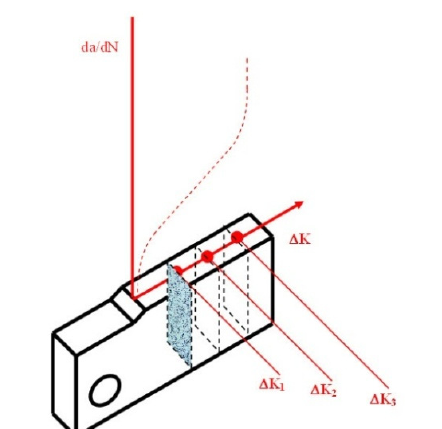
Figure 12: Light optical microscope (LOM) transversal crack paths